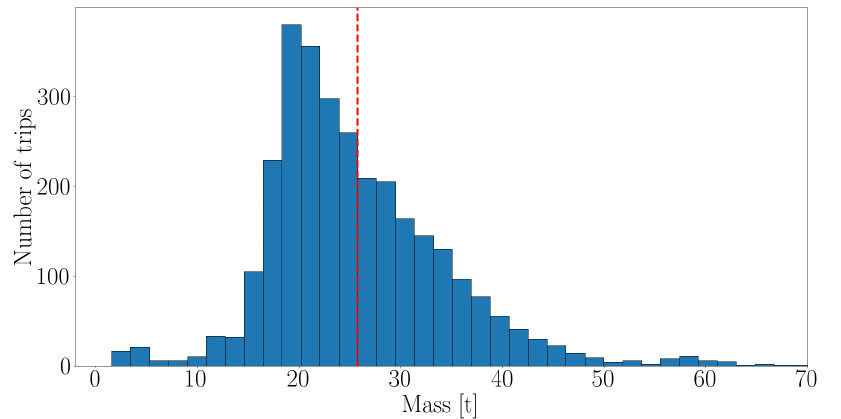
Figure A1. Distribution of the total mass of the vehicles (tractor and load). The mean value is indicated in